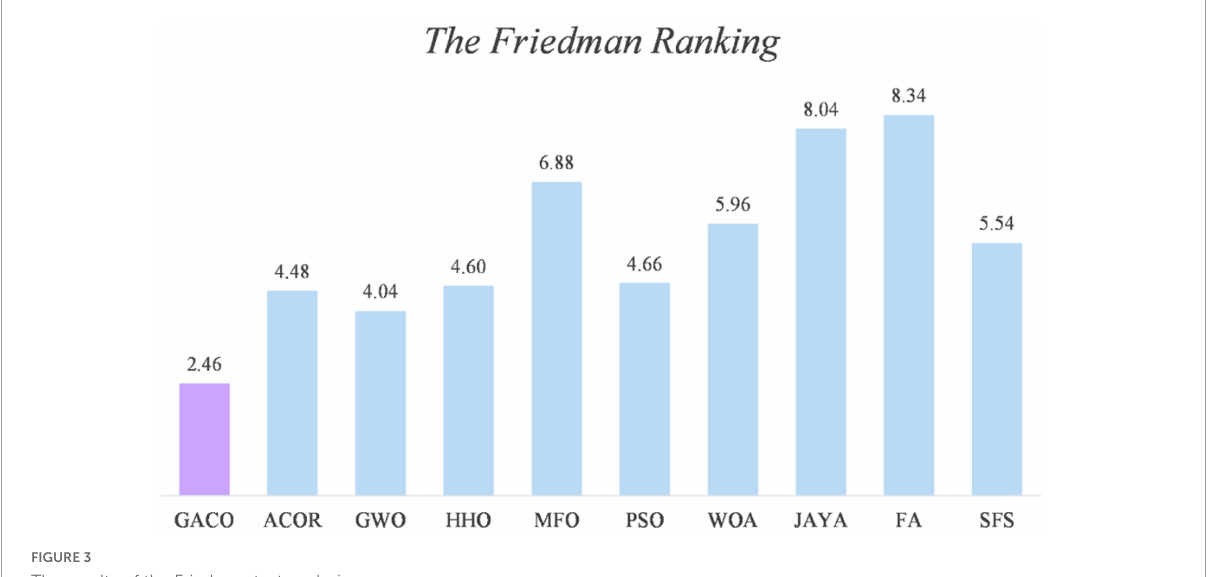
FIGURE3 The results of the Friedman test